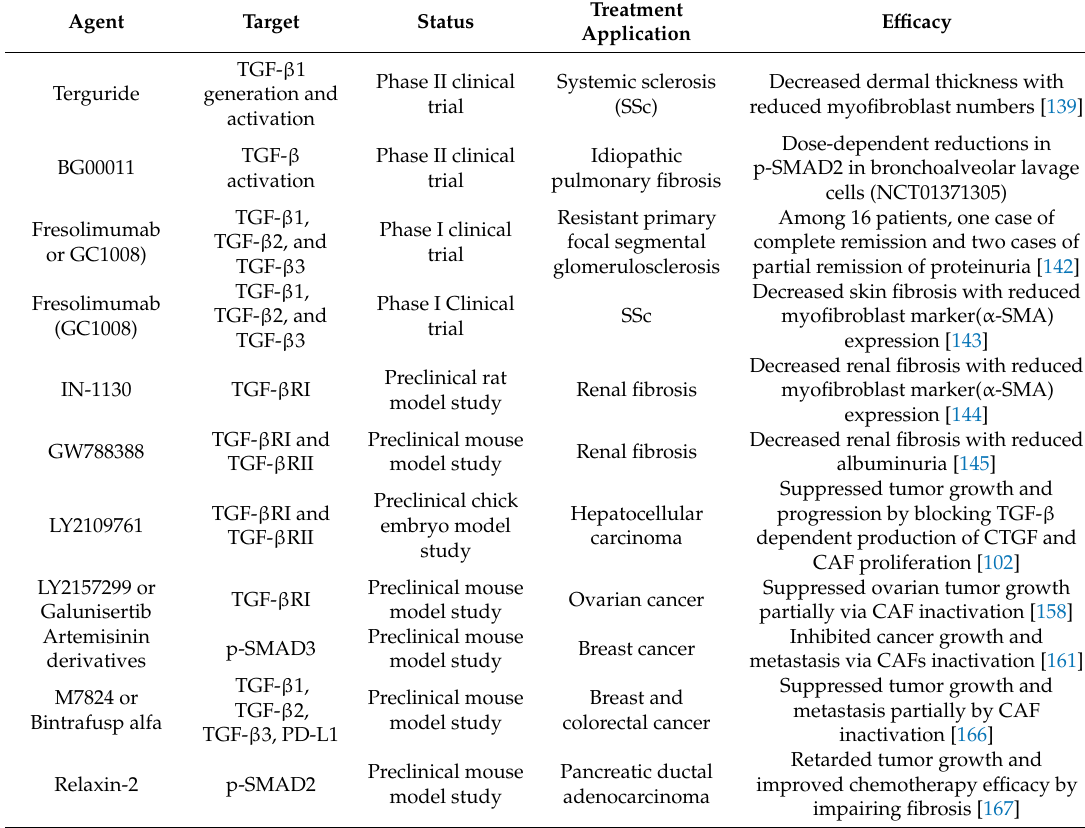
Table 1. Therapeutic agents that target TGF- β signaling in fibrosis and CAF-mediated cancer